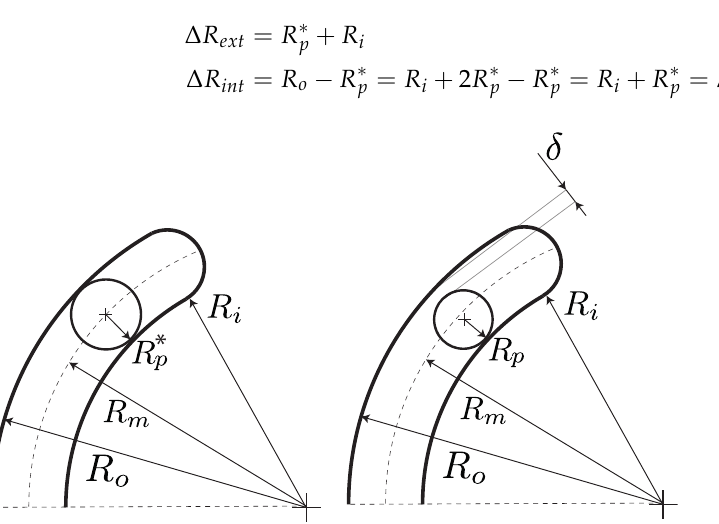
Figure 9. Scotch-yoke linkage, without ( left ) and with clearance ( right